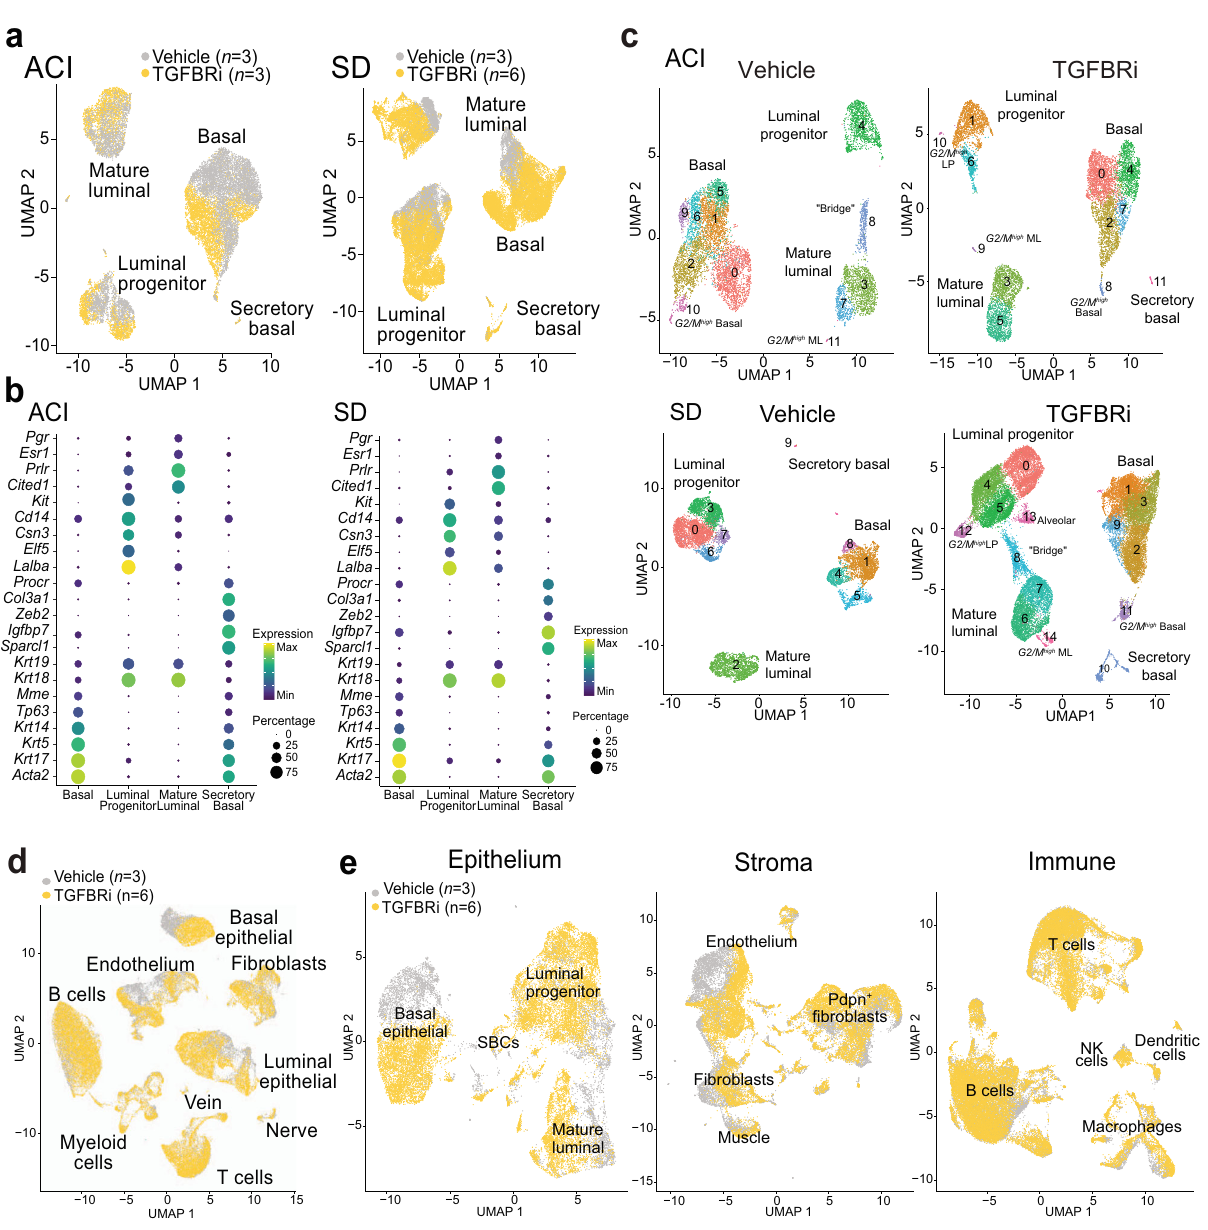
from the vehicle and TGFBRi-treated ACI and SD rats. d , e UMAP plots of whole mammaryglandscRNA-seqdatafromSDratspreprocessed and analyzedtogether ( d ) or separately for each major cell type ( e ). Cells are colored by treatment con- dition ( a , d , e ) or by cluster assignment ( c